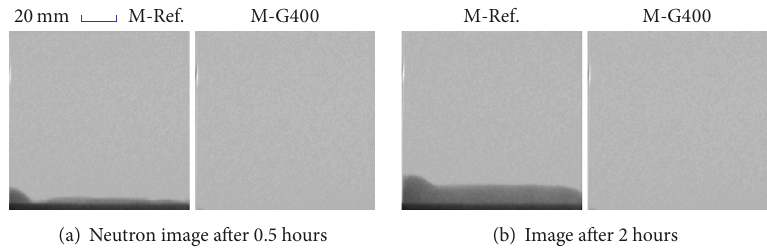
Figure 6: Observations of water penetration into mortar specimens after 0.5 and 2 hours by means of neutron radiography.